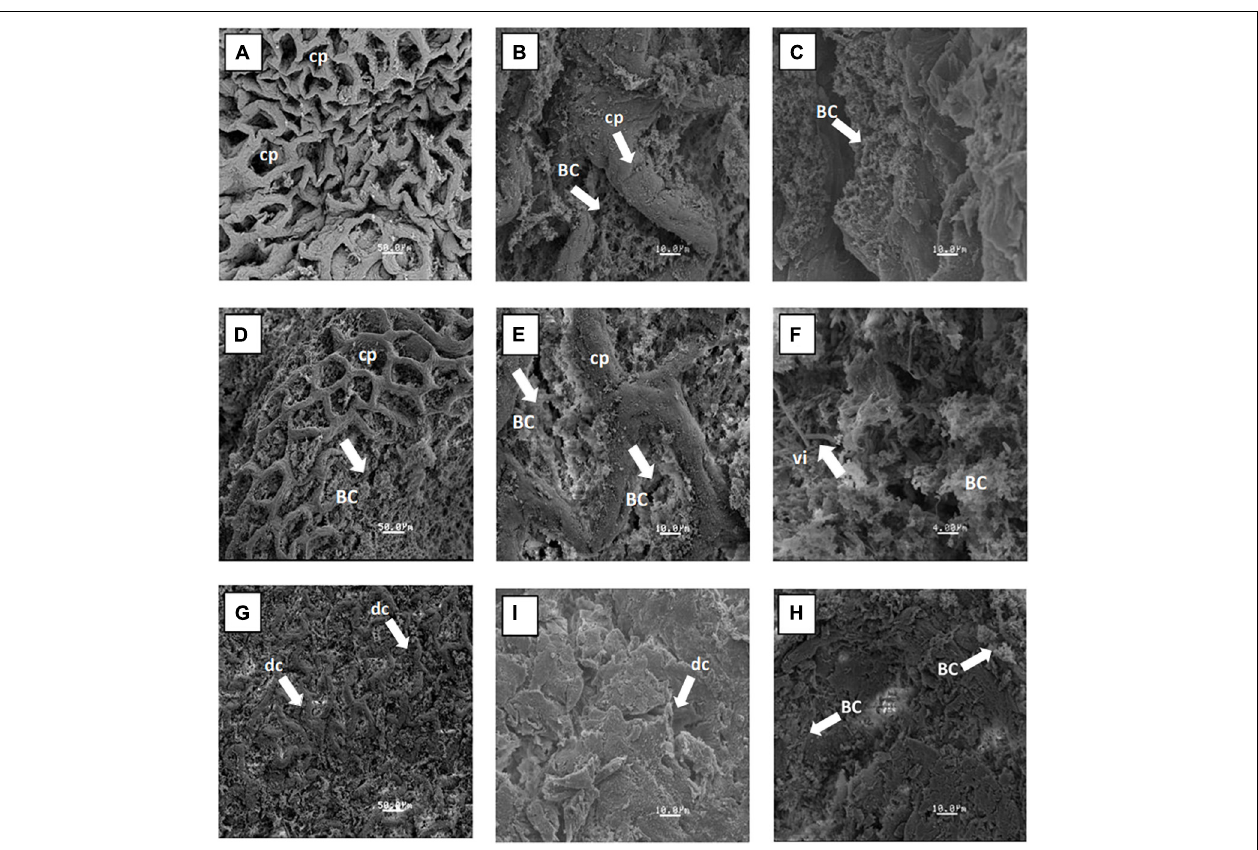
FIGURE 4 | Scanning electron micrograph images of the general structure of epithelium and bacteria adhering to the mucus layer of rats fed with fructans at the following doses: dose 0% (A,B) cecum and (C) proximal colon; 12.5% (D,E) cecum and (F) proximal colon; and 15% (G,H) cecum, and (I) proximal colon. BC, bacterial colonization; cp, crypts preserved; dc, disruption of crypts; vi, villus.